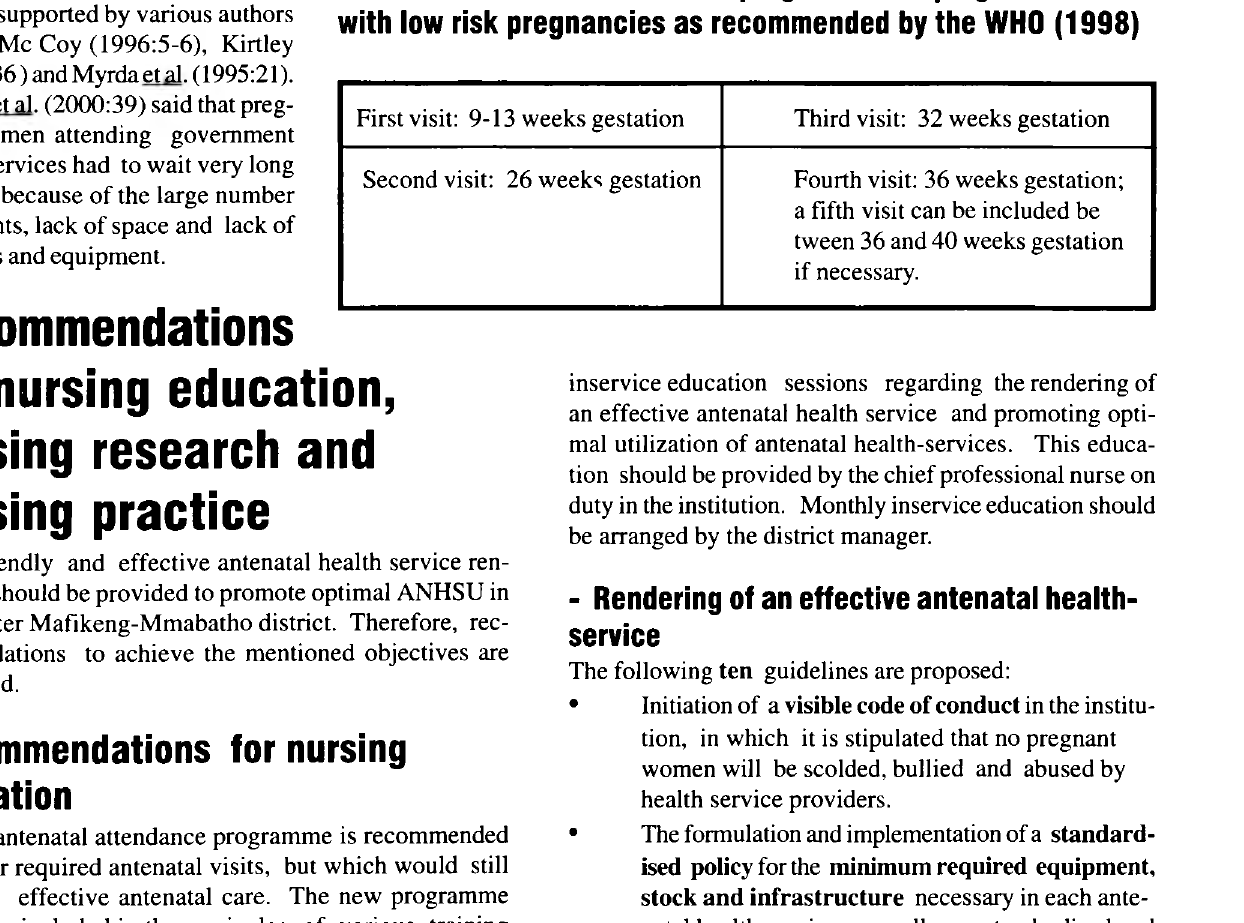
Table 2: Antenatal attendance programme for pregnant women with low risk pregnancies as recommended by the WHO